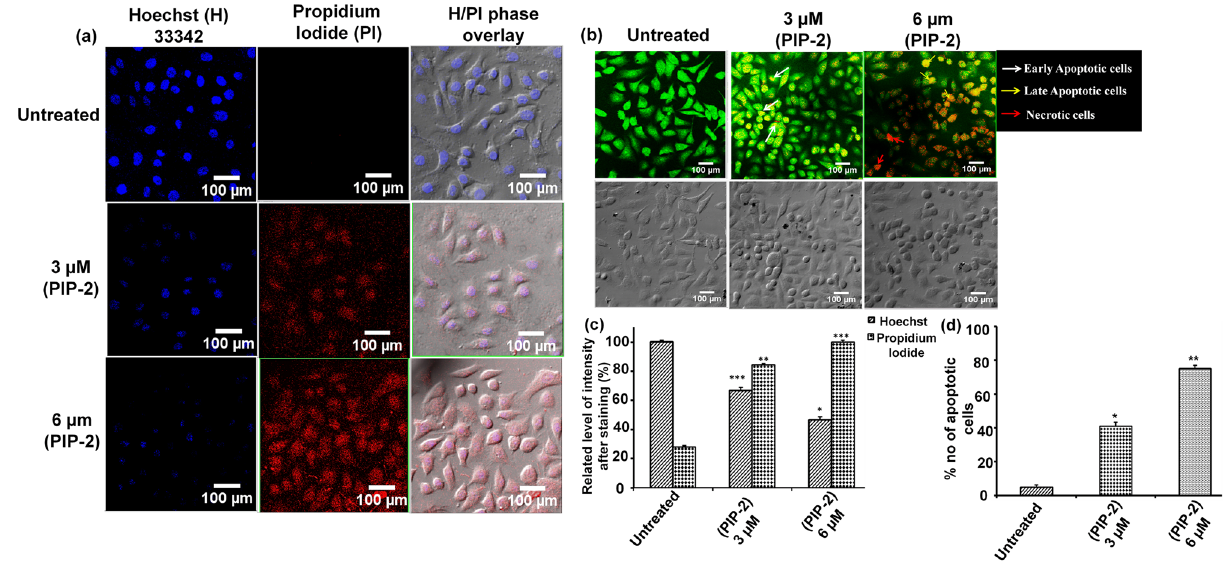
Figure 9. Morphological analysis of A549 cells upon treatment with PIP-2 through different DNA staining dye. ( a ) A549 cells treated with PIP-2 and dual staining was performed with Hoechst 33342/Propidium Iodide (PI). ( b ) The Composite images represent the Acridine orange/Ethidium Bromide (AO/EtBr) stained A549 cells after treatment Piperine analog PIP-2. The white, yellow, and red arrows indicate the early apoptotic, late apoptotic, and necrotic cells, respectively. ( c , d ) The bar graph represents the quantitative analysis of H/PI and AO/EtBr dual staining results calculated through Image J. The results are the sum of three separate sets of experiments, with collected values expressed as means ± standard deviation. The statistical significance derived from the Student’s t-test (*P < 0.05, **P < 0.01, ***P < 0.001) by analyzing the control (untreated) group is indicated by the asterisks. 100 µm scale